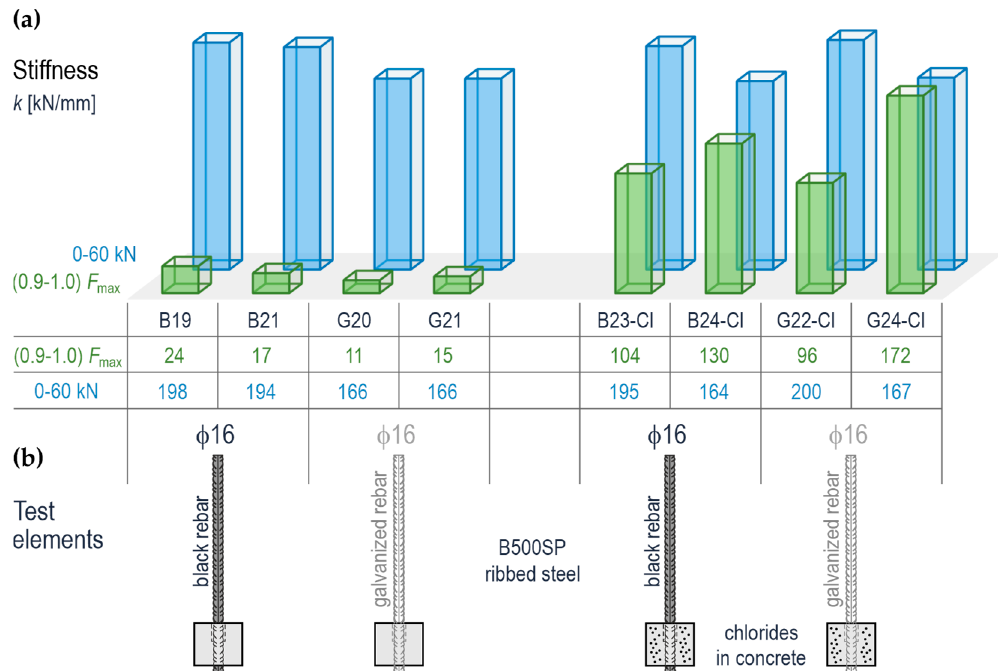
Figure 17. Anchorage stiffness of ribbed (galvanized and black steel) rebars φ 16 mm in concrete (with and without chlorides) determined for two loading phases: phase 1—0–60 kN, phase 2—(0.9–1.0) F max : ( a ) stiffness of the test elements, ( b ) the test elements.